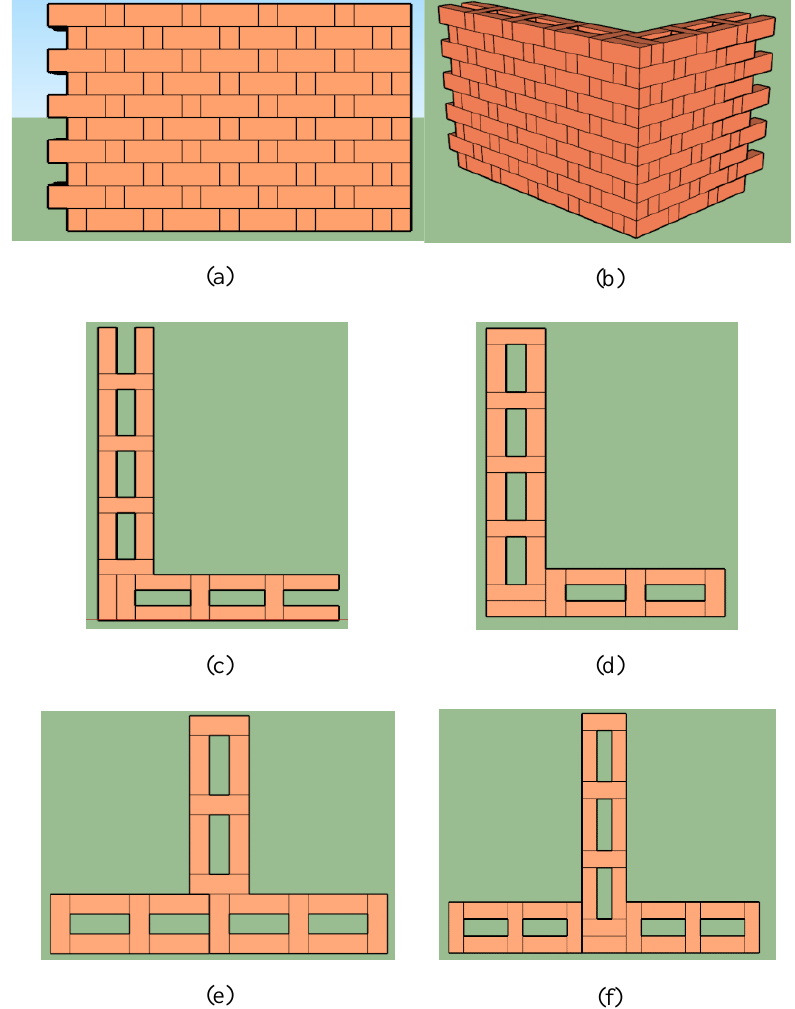
Fig. 1. Construction details and layouts of RTB (a) front view of RTB wall (b) typical arrangements in RTB (c) L joint in RTB first course and (d) second course (e) T joint in RTB first course and (f) second